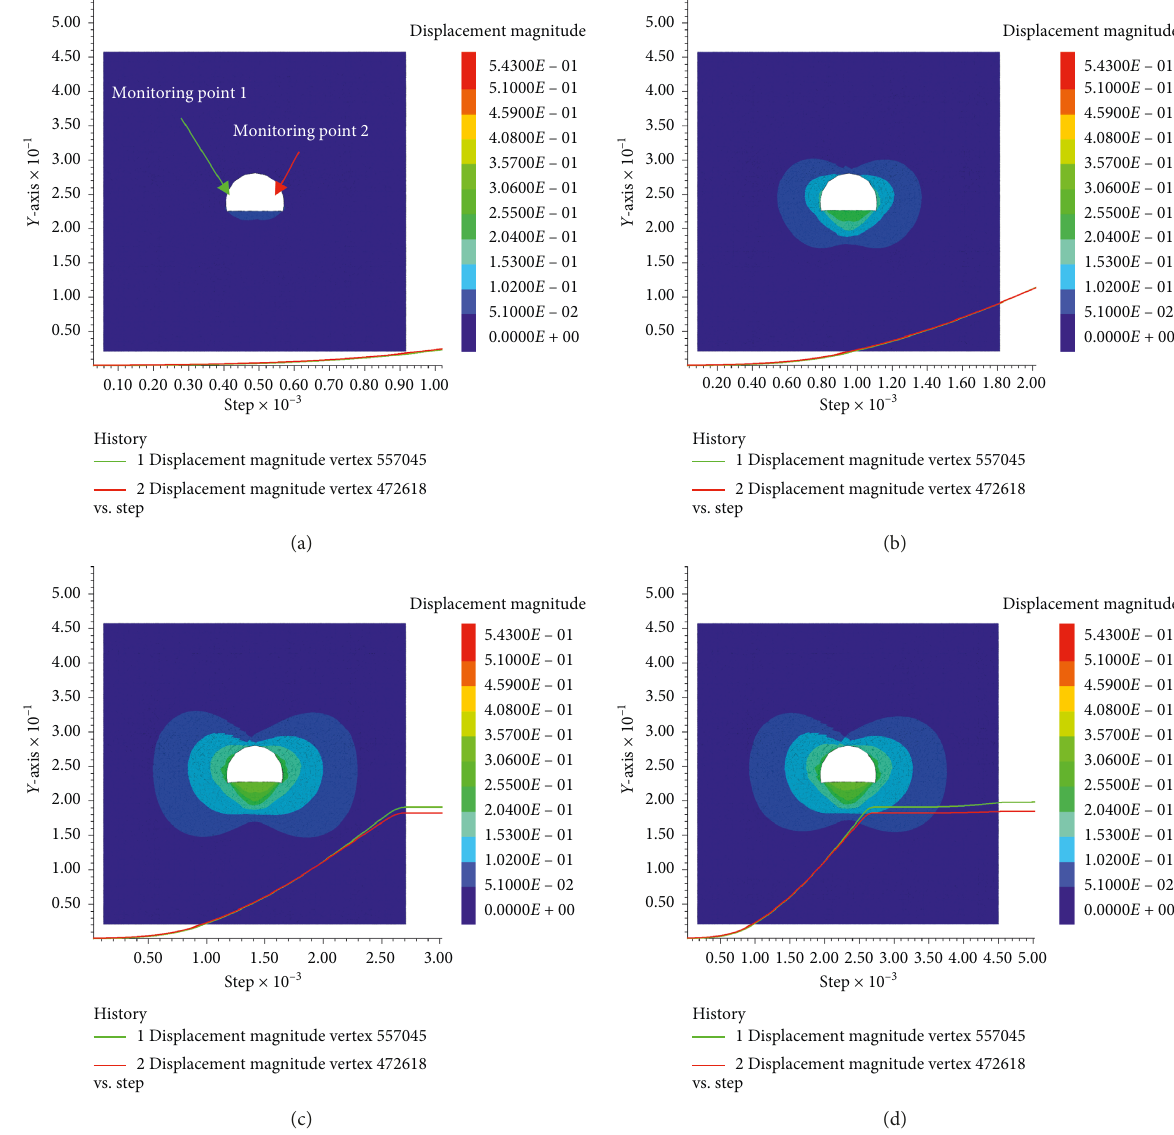
Figure 16: Surrounding rock displacement nephrogram with the anchor cable support. (a) Step 1000, (b) step 2000, (c) step 2700, and (d) step 5000.